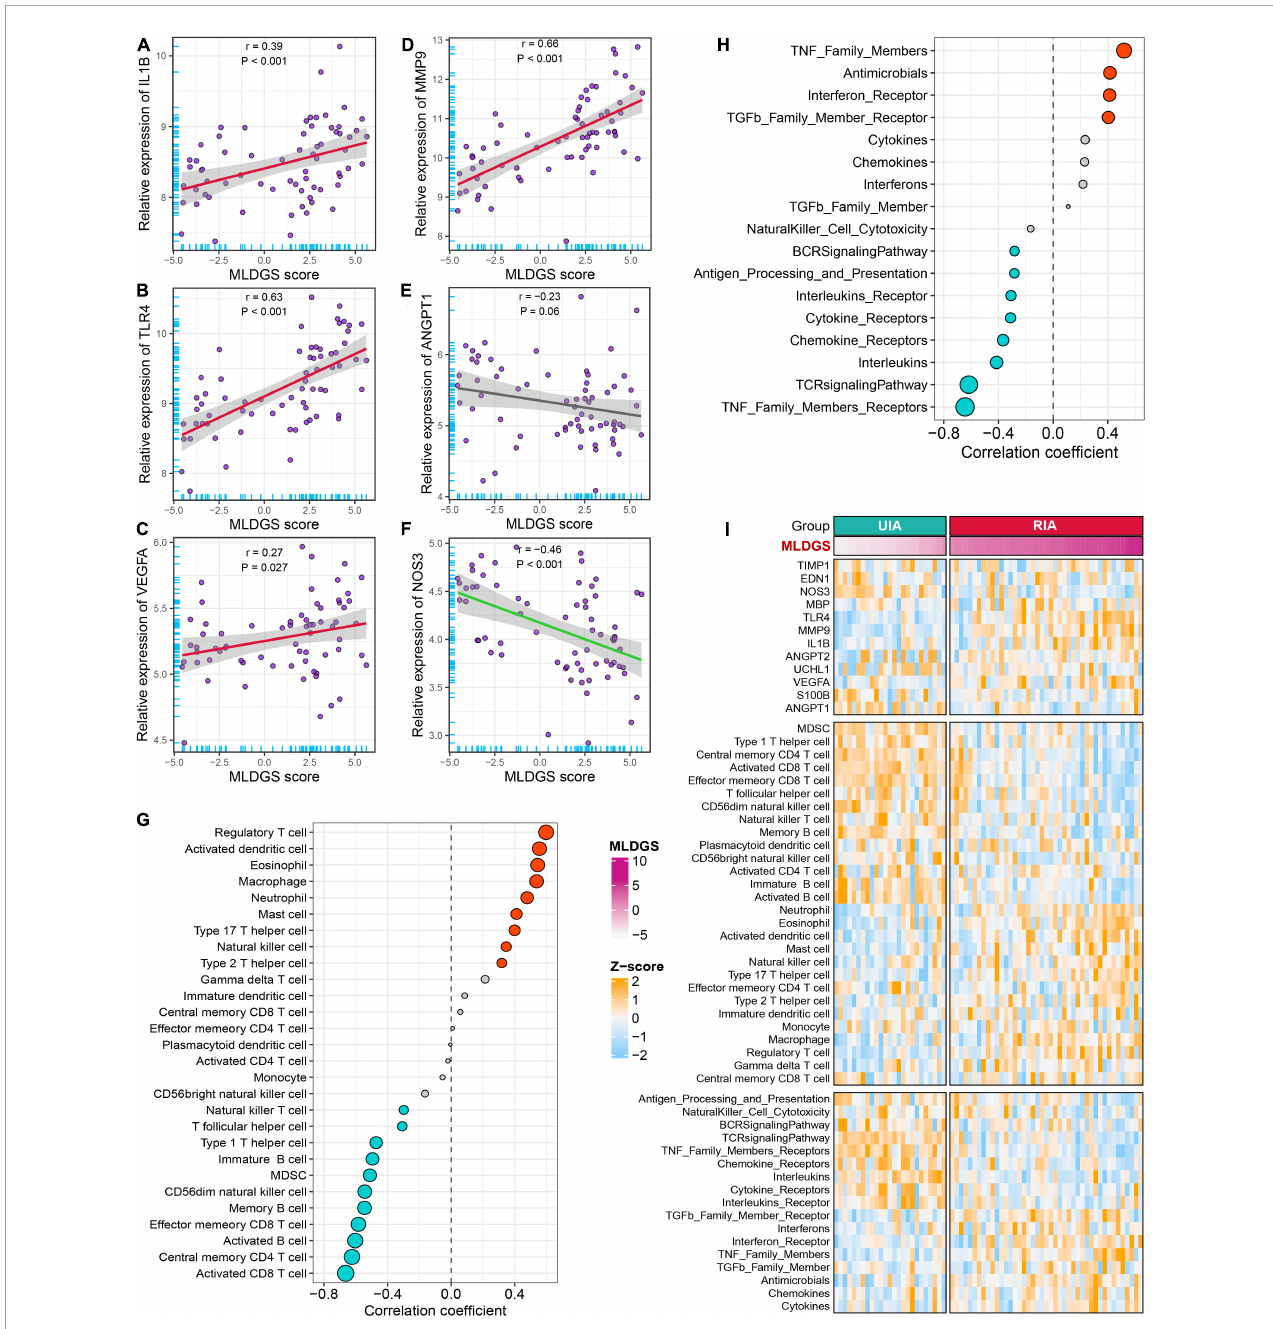
FIGURE6 Relationships between the MLDGS and immunopathological features. (A–F) Correlation analysis of MLDGS score with the expression of IL1B (A) , TLR4 (B) , VEGFA (C) , MMP9 (D) , ANGPT1 (E) , and NOS3 (F) . (G,H) Relationship between MLDGS and immune cells and immune-related gene sets. Red and turquoise represent significant positive and negative correlations, respectively. (I) Global landscape of the relationship between MLDGS and various immunopathological features. Statistics: Pearson’s correlation; two-sided t